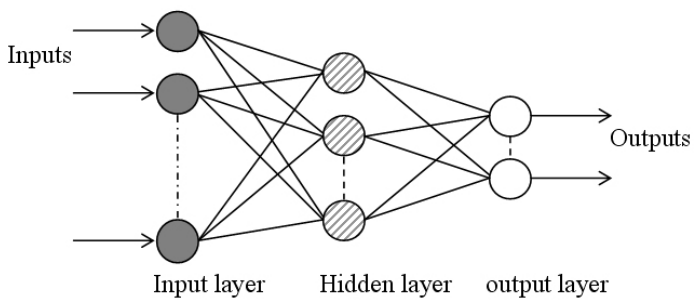
Figure 1. Schematic diagram of back propagation neural network